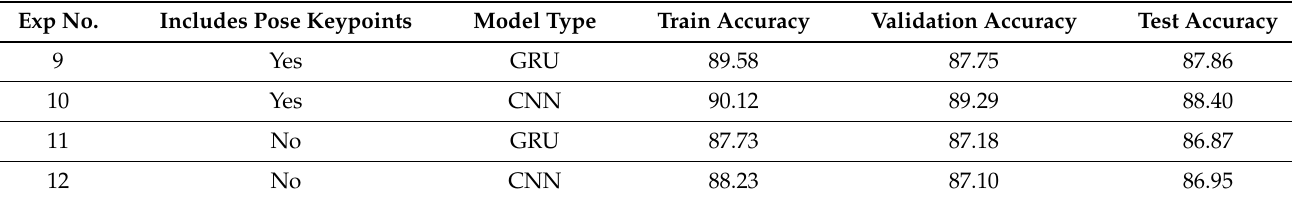
Table 7. Experiments results on the LIBRAS-BSL